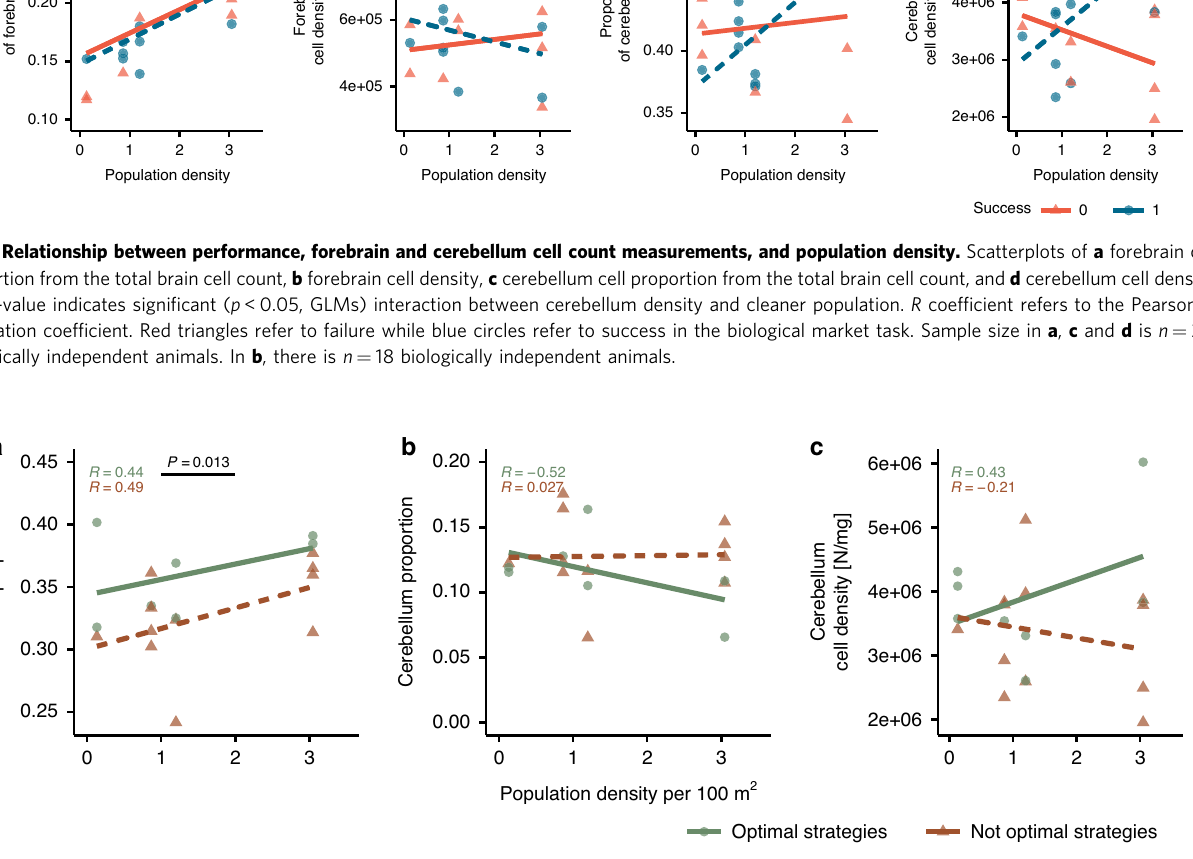
Fig. 4 Relationship between locally adaptive behavioural strategies, forebrain and cerebellum measurements, and population density. Scatterplots of a forebrain size proportion, b cerebellum size proportion, and c cerebellum cell densities. Cleaner performance is categorised here as either optimal or not- optimal strategies as a function of population density (see ‘ Methods ’ section). The p- value indicates signi fi cant ( p < 0.05, GLM) differences in forebrain size between individuals with optimal strategies and those with not-optimal strategies. R coef fi cient refers to the Pearson correlation coef fi cient. Green circles refer to optimal strategies while brown triangles refer to not-optimal strategies within social competence context. Sample size in a and b is n = 18 biologically independent animals. In c , there is n = 20 biologically independent